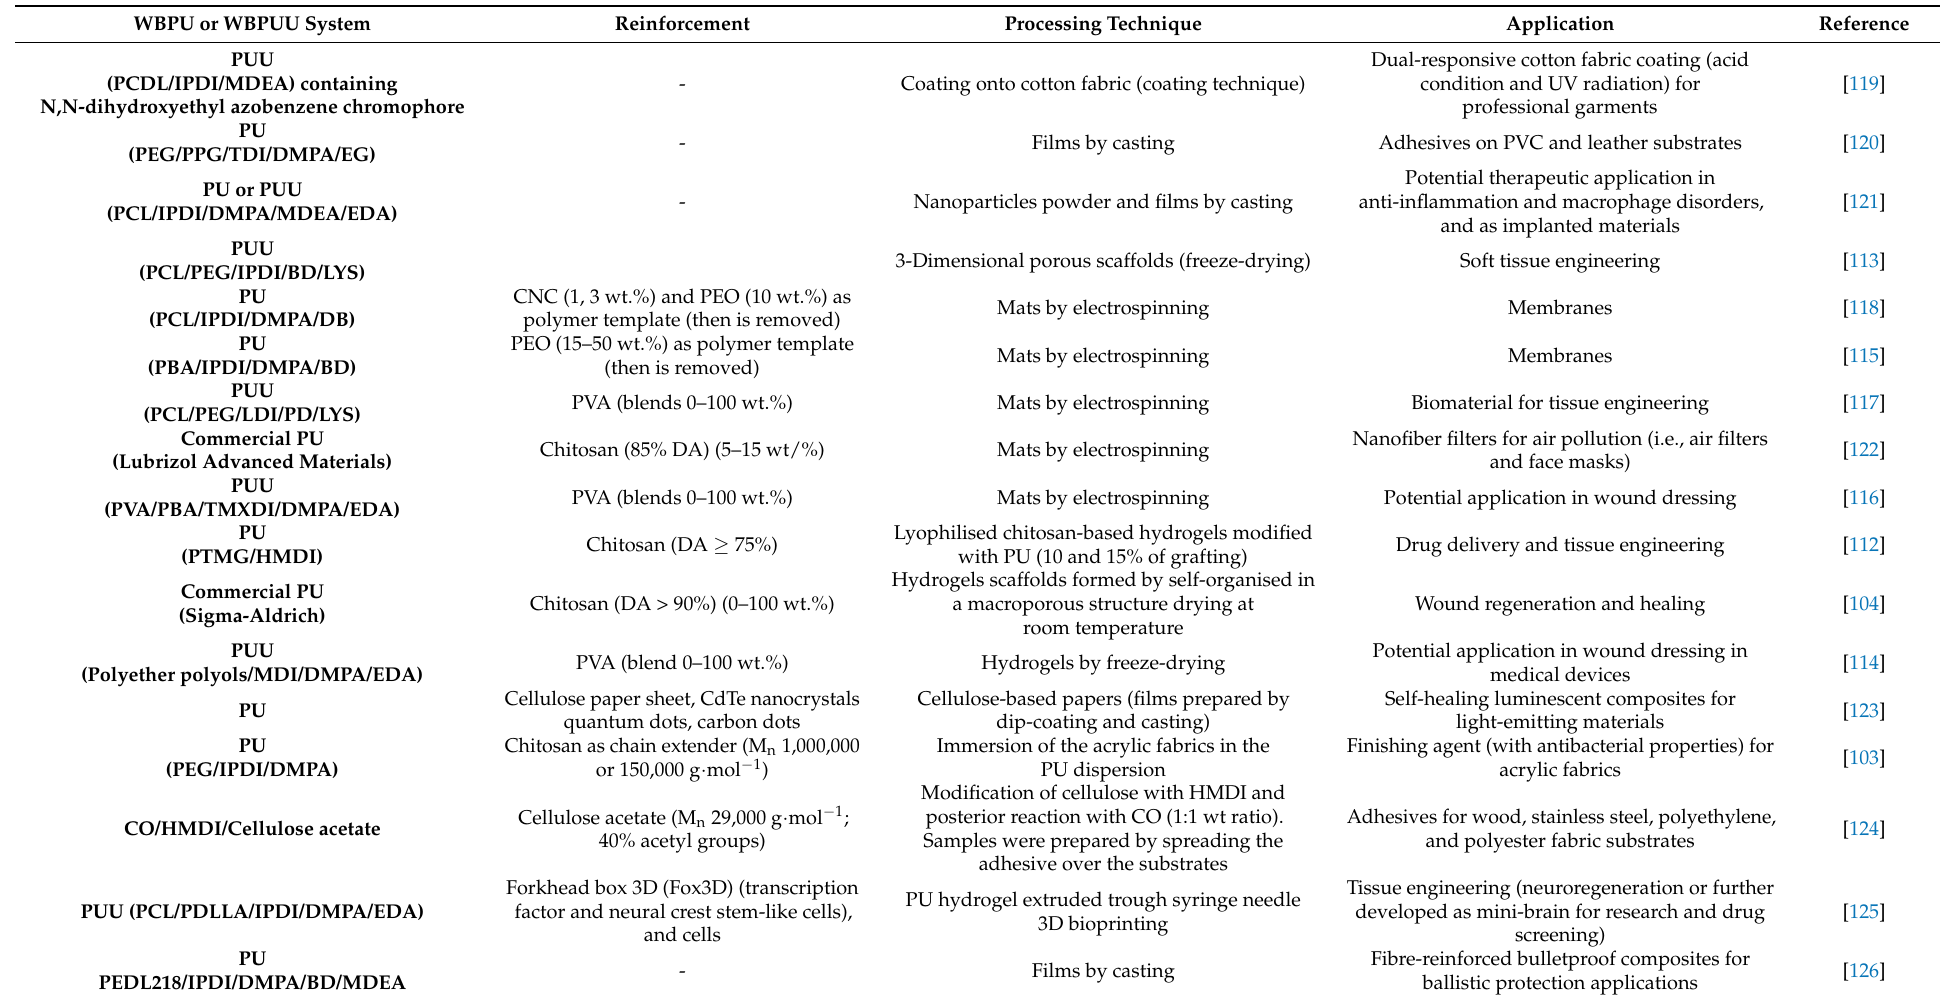
Table 4. Processing technique of WBPU and WBPUU systems and their